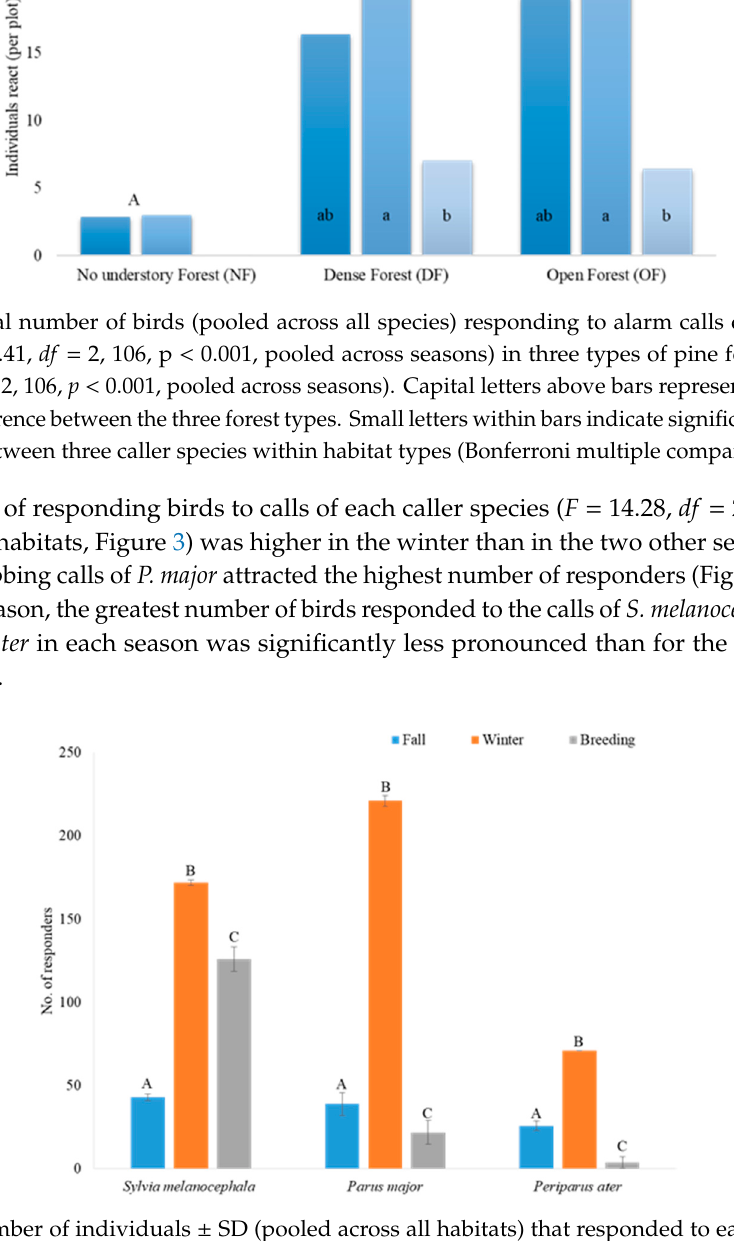
Figure 3. Number of individuals ± SD (pooled across all habitats) that responded to each mobbing caller type in each season. Letters above bars indicate significant ( p < 0.05) difference between seasons within each bird species (Bonferroni multiple comparisons).